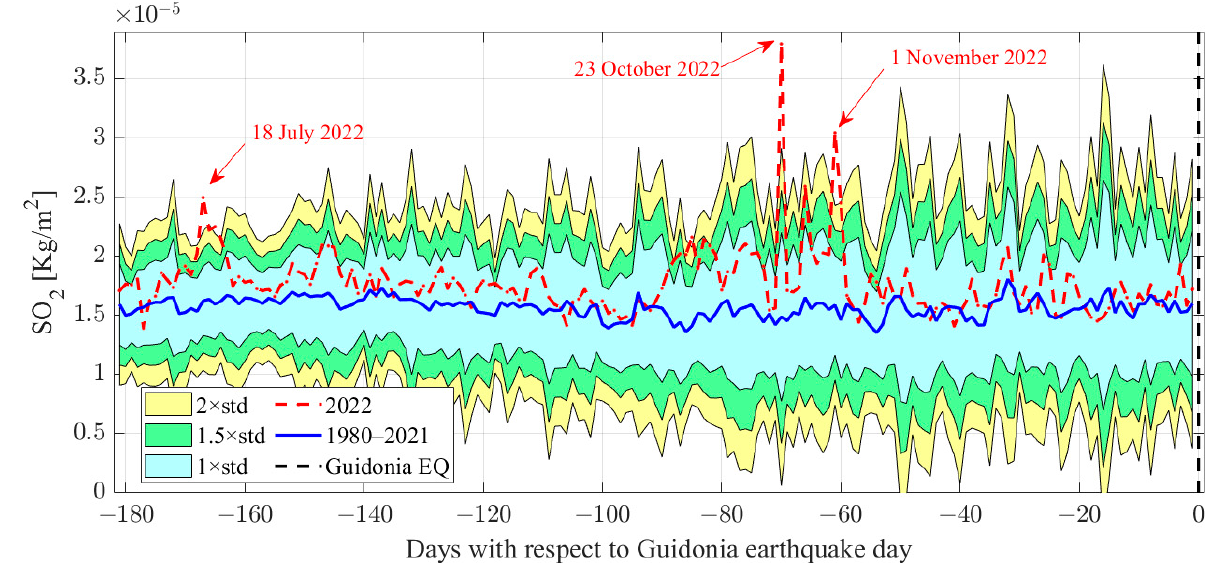
Figure 5. SO 2 time series from 4 July 2022 until 31 December 2022 (i.e., from six months before until the day before the ML = 3.3 1 January 2023 Guidonia earthquake). The years 1985, 1989, and 1993 have been excluded automatically as particularly anomalous. The representation graphic is the same as Figure 4.